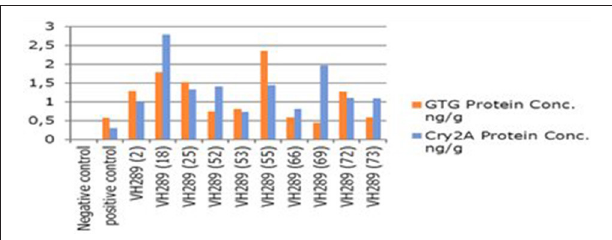
FIGURE 8 | Comparison concentration of GTG gene Cry2A gene protein of transgenic cotton plants at T0 generation. Lane 1 represents control cotton plant, Lane 2 shows positive control, Lane 3–12 represent cotton plants.